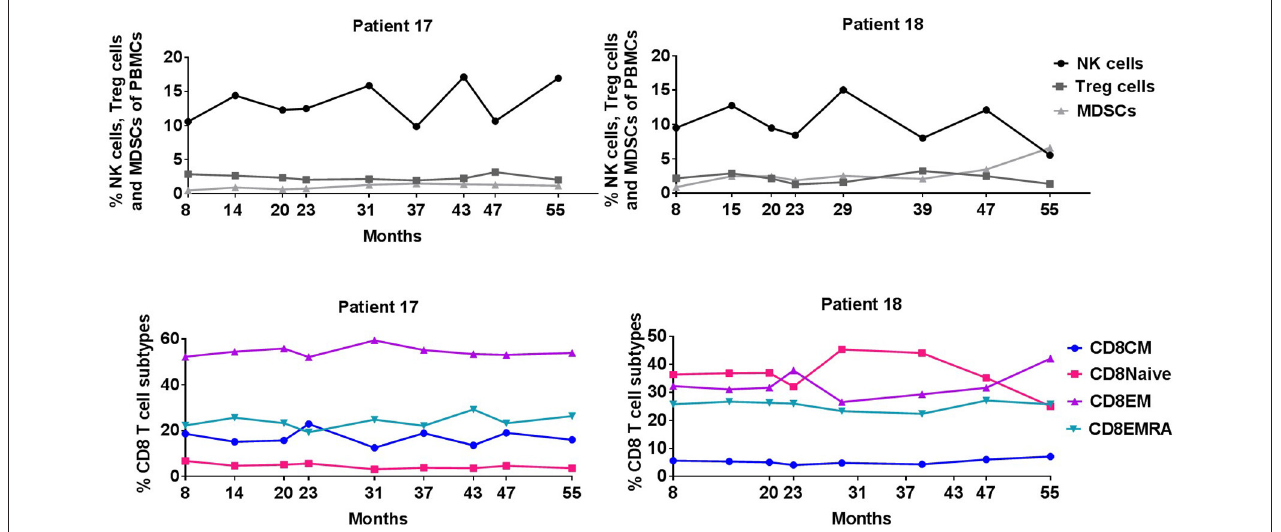
FIGURE 3 | Percentage of NK cells, Treg cells, MDSCs, and CD8 + T cell subpopulations during IDO vaccination